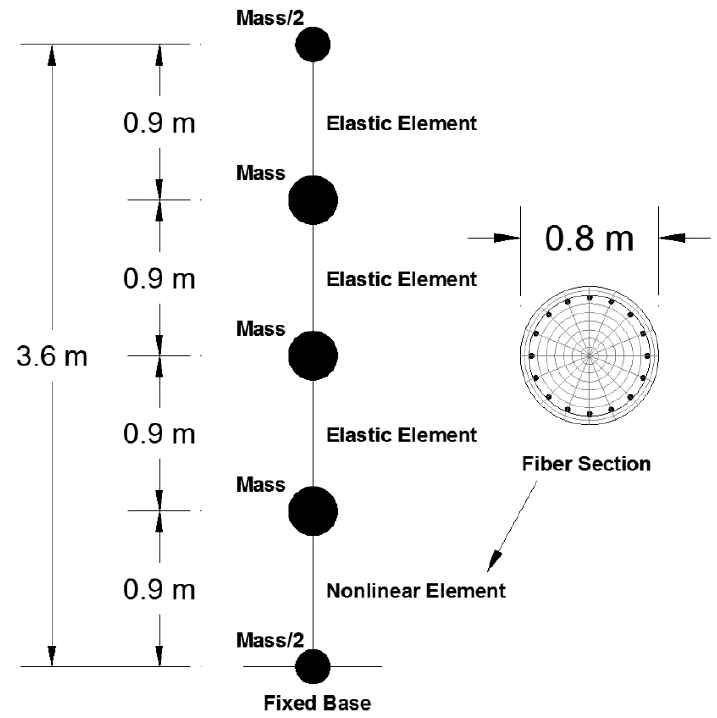
Figure 2. Column model in OpenSees.